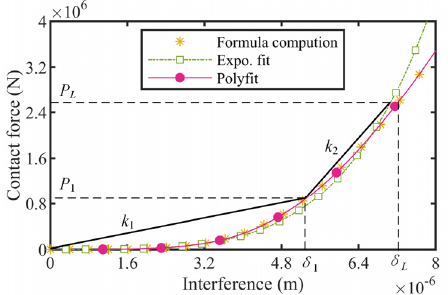
Figure 7. Approximation of screw–nut contact characteristic.